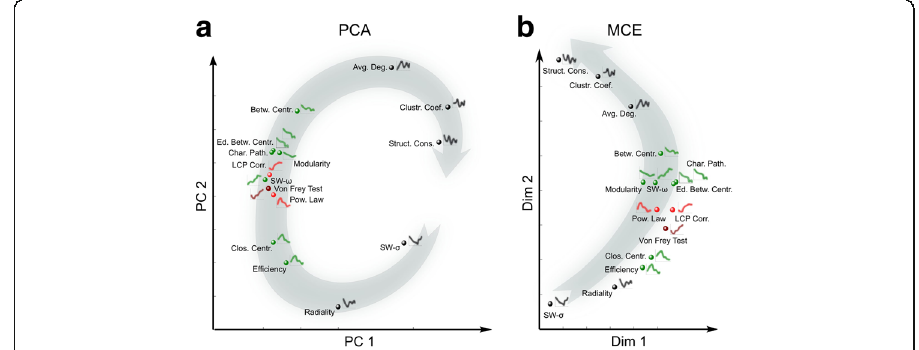
Fig. 4 The figure shows two methods for linear and nonlinear multivariate analysis: ( a ) Principal Component Analysis (PCA) and ( b ) Minimum Curvilinearity Embedding (MCE). PCA is a method for linear dimensionality reduction and the points on the PCA plot (representing the various topological measures) are distributed according to a circular pattern, which suggests the presence of non-linear relationships among the data points. MCE is a non-linear method for dimensionality reduction, therefore the data points are distributed more linearly compared to PCA. The X and Y axes of ( a ) are the principal components (PC) 1 and 2 respectively. The X and Y axes of ( b ) are the dimensions 1 and 2 of the embedding. Since multivariate analysis considers the overall strength of relationships between each pair of variables (individual data points of each plot), the topological measures with curves of similar shape tend to be closer in the reduced space. For instance, LCP-correlation and Power Lawness, which have high correlation values and a similar shape with respect to Von Frey test, are also close to each other. Points corresponding to topological measures with medium-high correlation values are shown in the same color as in Fig. 3, whereas measures in the low correlation range are colored in